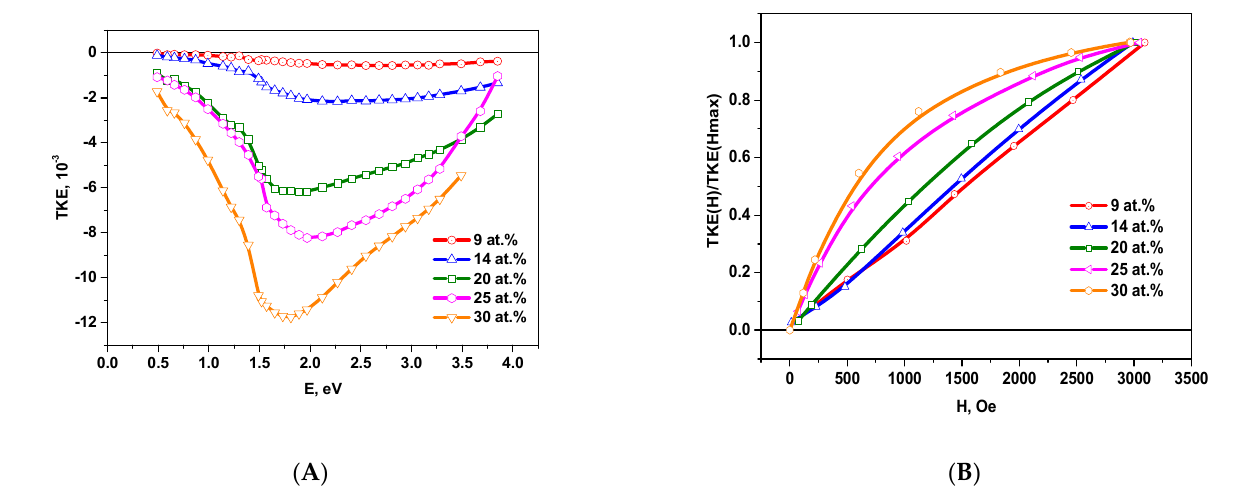
Figure 4. Spectral TKE(E) ( A ) and normalized field TKE(H)/TKE(Hmax) ( B ) dependences for composites on the glass substrates with metal phase concentrations x ≤ 30 at.%.